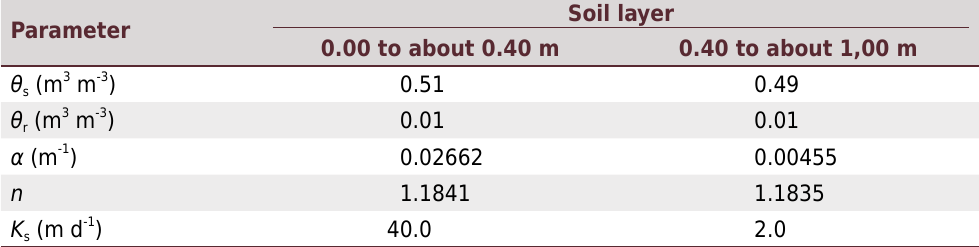
θ s and θ r are the saturated and residual soil water contents, respectively; α and n are the shape parameters of the retention and conductivity functions, K s is the saturated hydraulic conductivity.